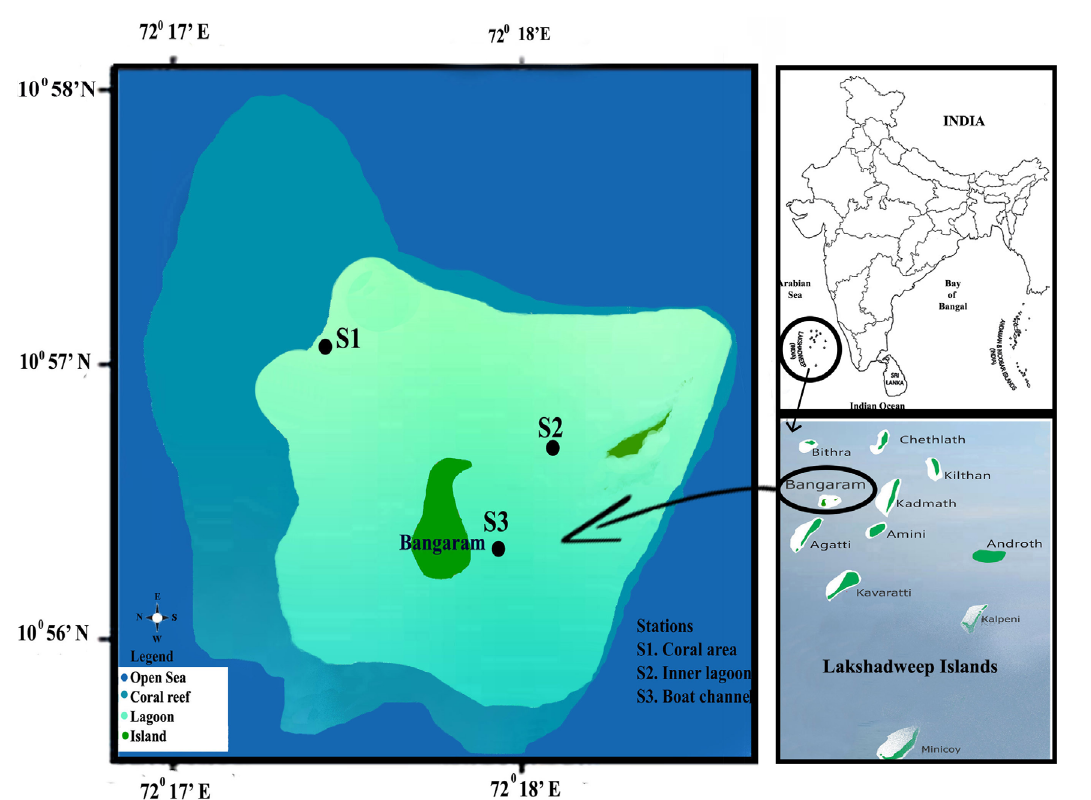
Figure 1. Map showing the sampling stations on Bangaram Island (10°56’27.38”N 72°17’29.02”E), Lakshadweep, Arabian